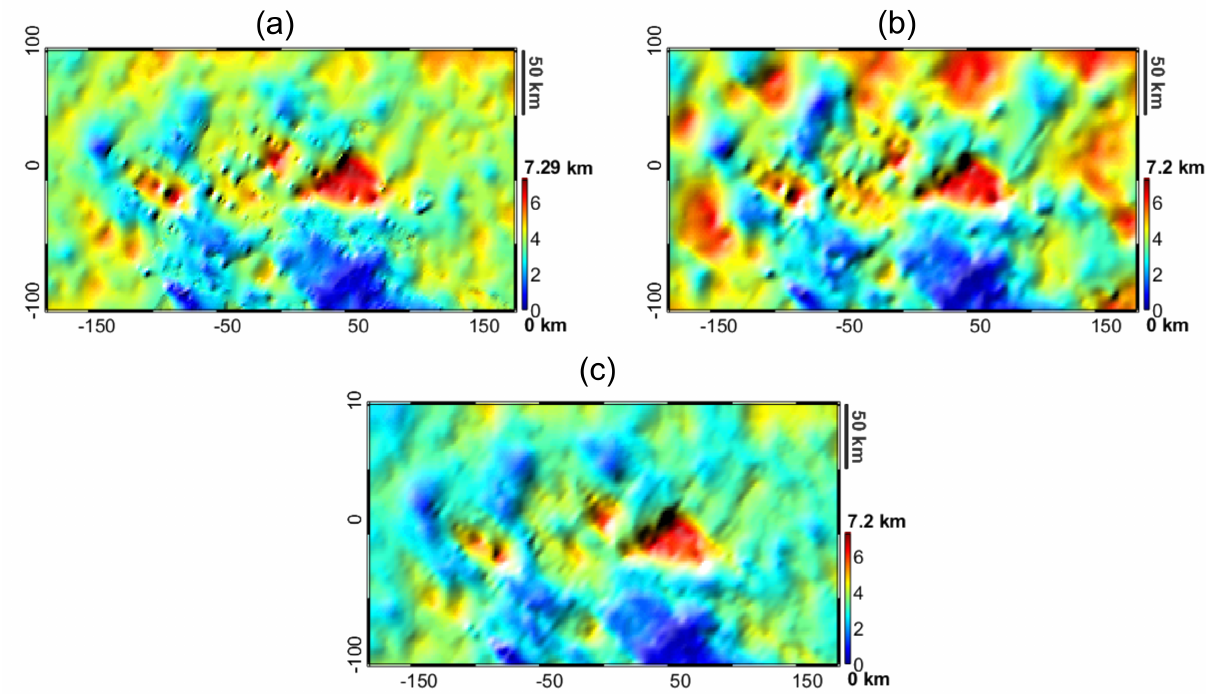
Figure 13. Base of the Messinian salt from the true ( a ), a priori ( b ) and a posteriori model ( c ). Table 4. Scenario 2 inversion: Statistics of the differences between true, a priori and a posteriori models. A-PRIORI vs. True Model A-POSTERIORI vs. True Model Layer Mean [m] STD [m] Mean [m] STD